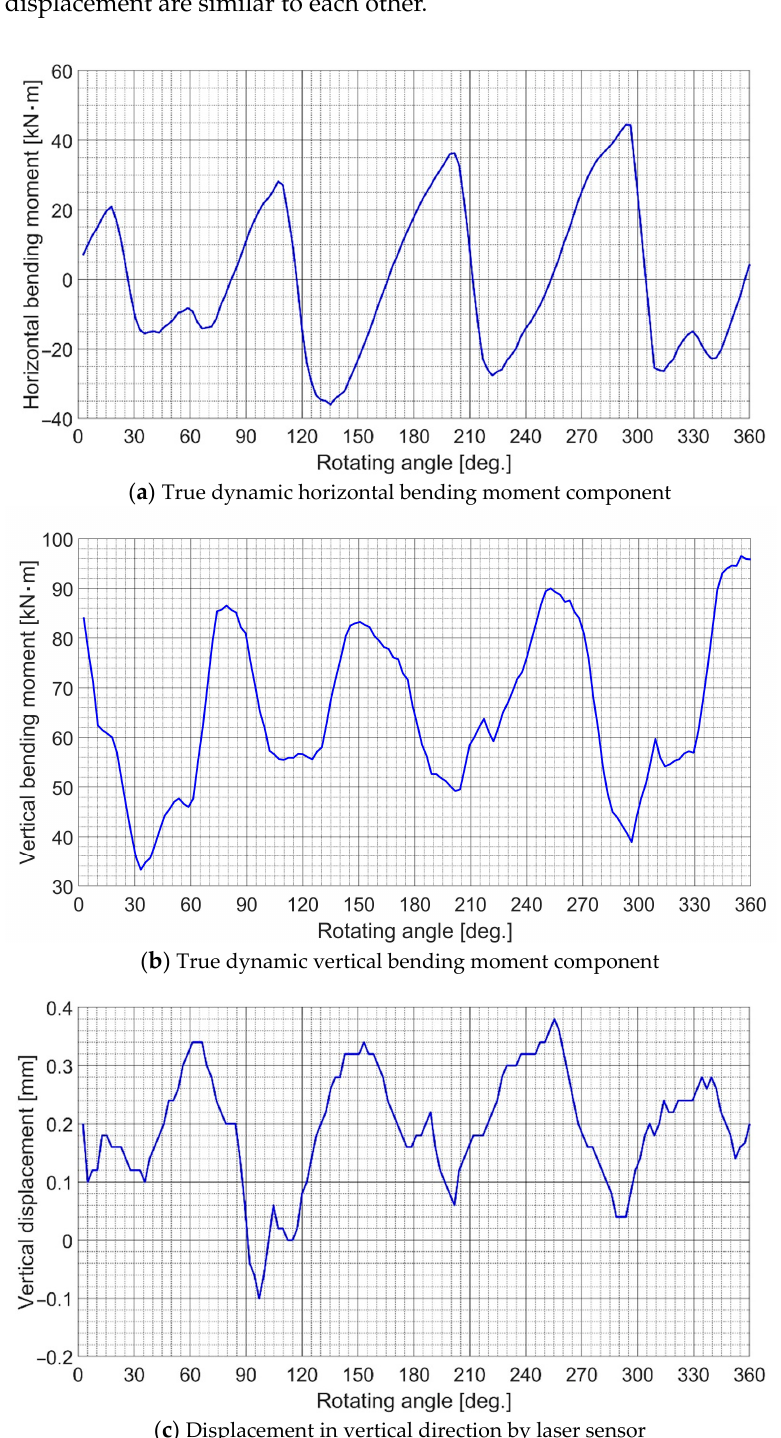
Figure 7. Vibration behavior during a full revolution during NCR straight going.